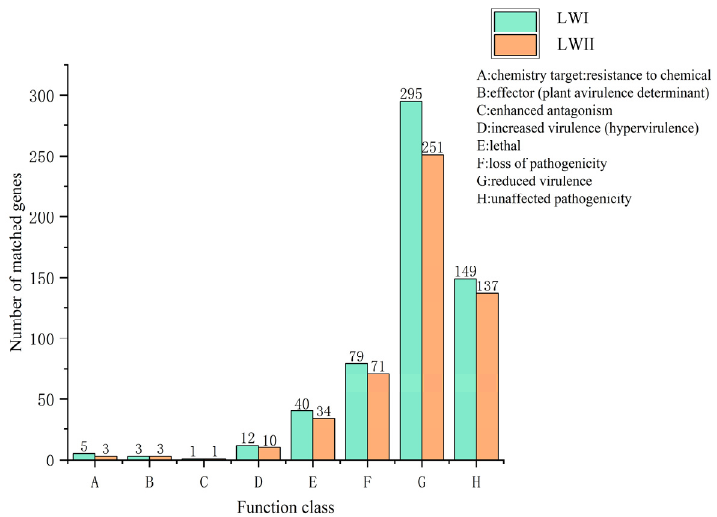
Figure 8. Pathogen–Host Interactions Database (PHI) annotation results of E. rostratum LWI and B. zeicola LWII.